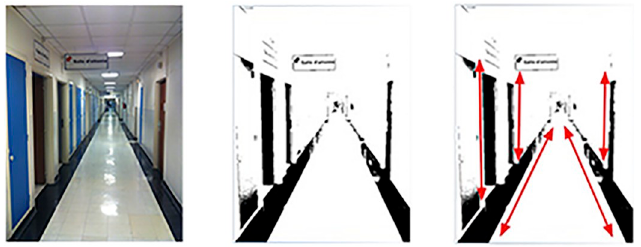
Fig 6. Decomposing visual space according to lines. The rehabilitation therapists are told by the companies to assume that the hallway is transformed by the device into a high contrast, black-and-white scene. The rehabilitation specialist then uses this visual to help guide the implant recipient (graphic representation by